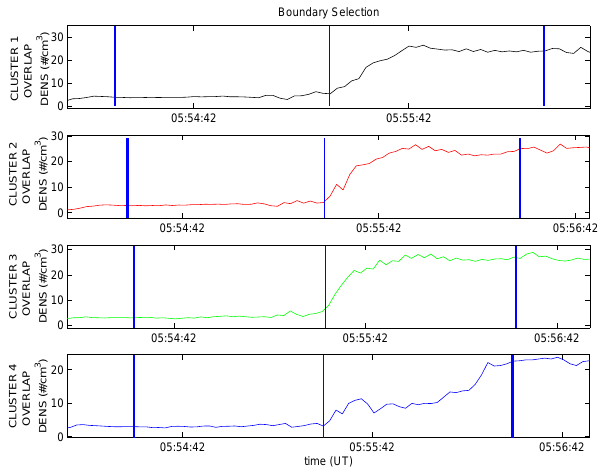
Fig. 3. Four spacecraft PEACE OVERLAP (35–1000eV) density data (spacecraft 1 in top panel through to 4 in bottom) used in the PTA technique. The chosen boundary position is indicated by the central thin vertical line, with a correlation window of ∼± 60s marked by thicker pairs of vertical